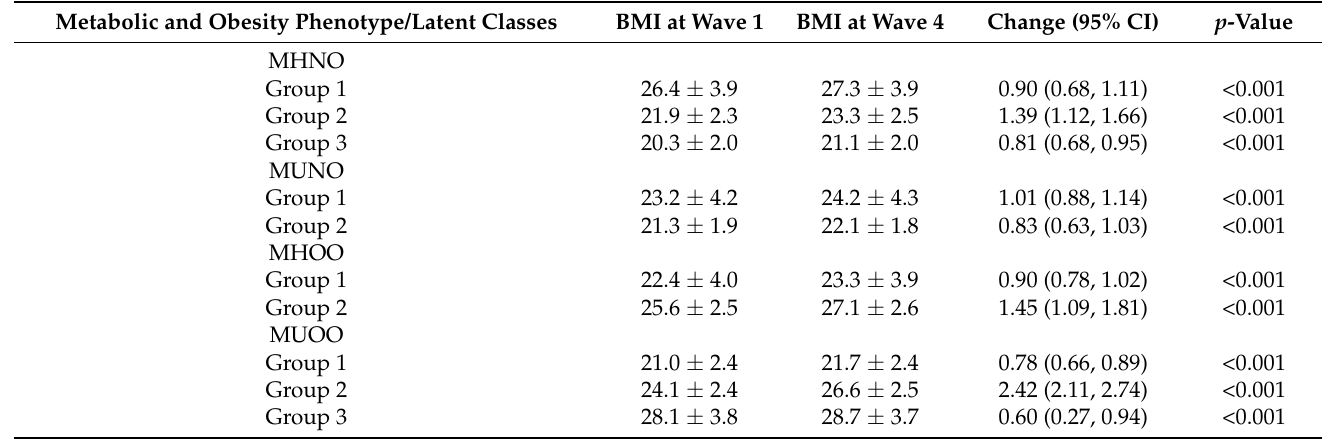
Table 5. The difference in BMI according to the latent classes of developmental trajectories for different metabolic and obesity